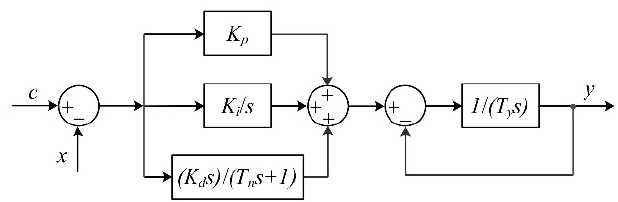
Figure 3. Block diagram of PID-type controller.